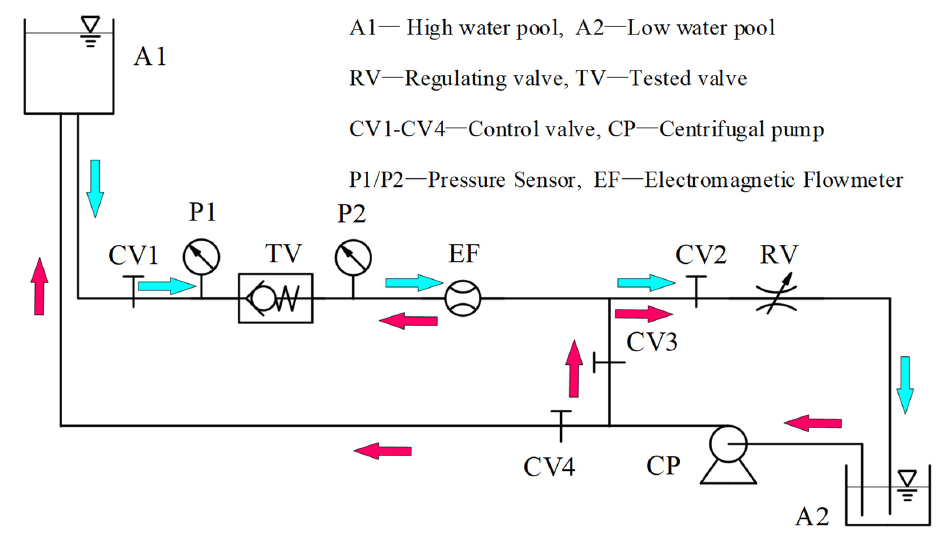
Figure 6. Dual disc check valve test system.